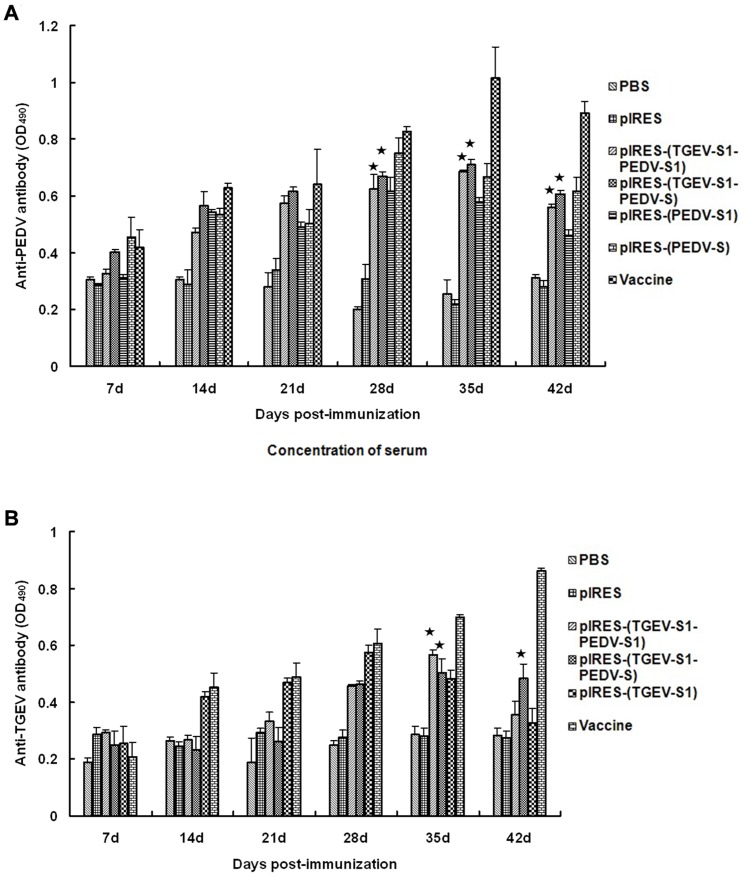
Antibody levels in mice treated with pIRES-(TGEV-S1-PEDV-S1) and pIRES-(TGEV-S1-PEDV-S).Anti-PEDV serum antibodies (A) and anti-TGEV serum antibodies (B) in pIRES-(TGEV-S1-PEDV-S1) and pIRES-(TGEV-S1-PEDV-S) immunized mice were detected by indirect ELISA at different time points following the injection of the plasmid DNAs. The OD490 was monitored as a function of time over a period of 42 days. ★: p<0.01 (highly significant), compared with PBS, pIRES treatment groups.